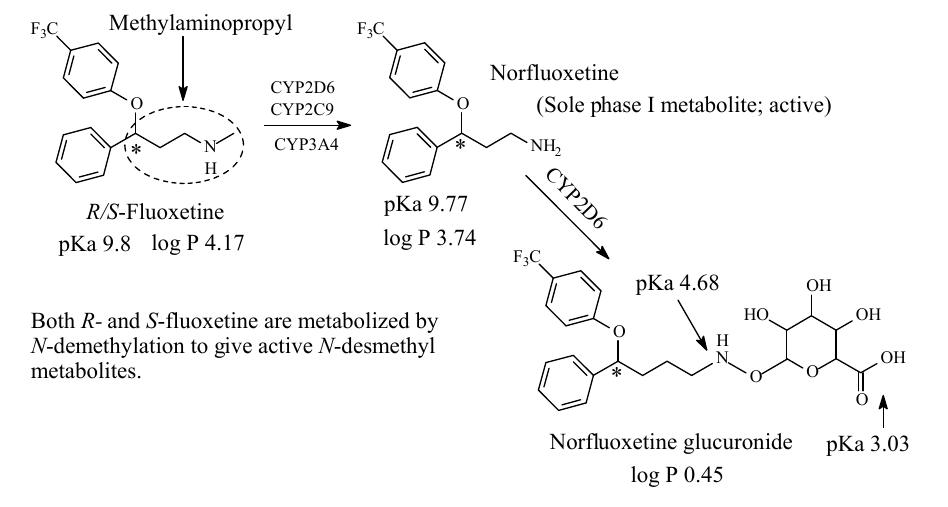
Figure 10. Metabolic pathway of fluoxetine.